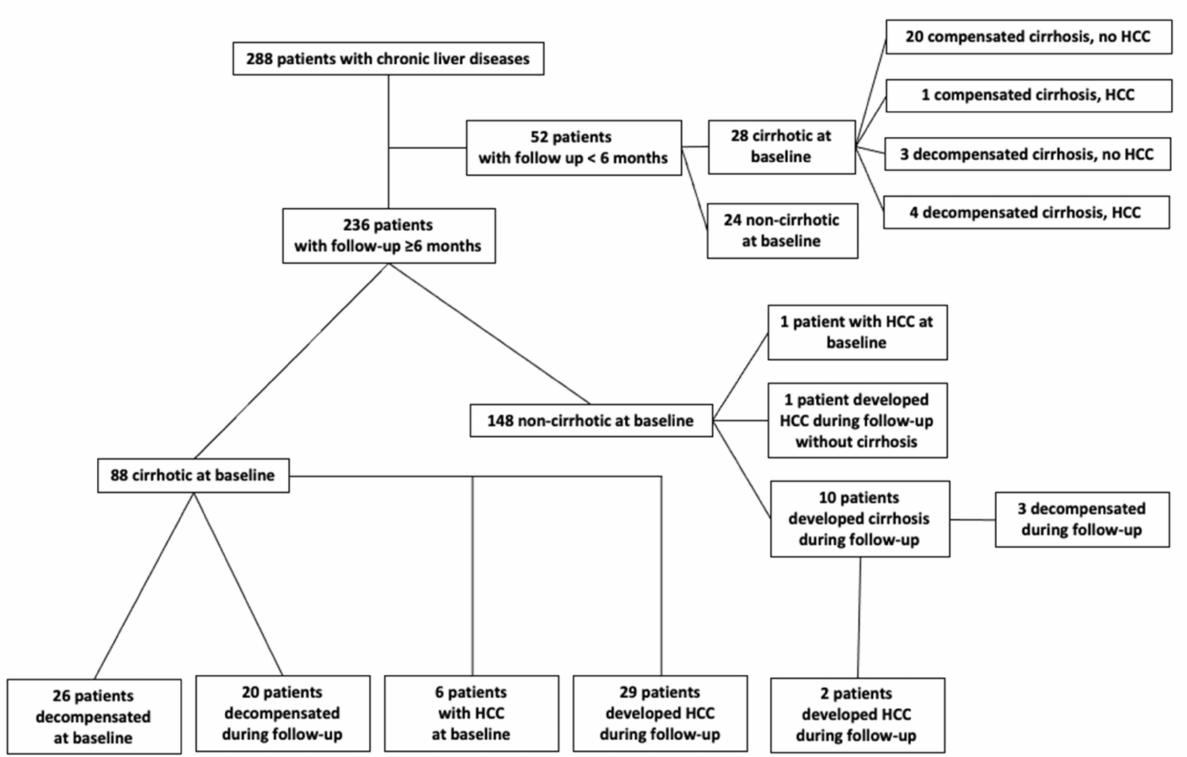
Figure 1. Flow-chart of the 288 patients that participated in the study and liver-related events observed during